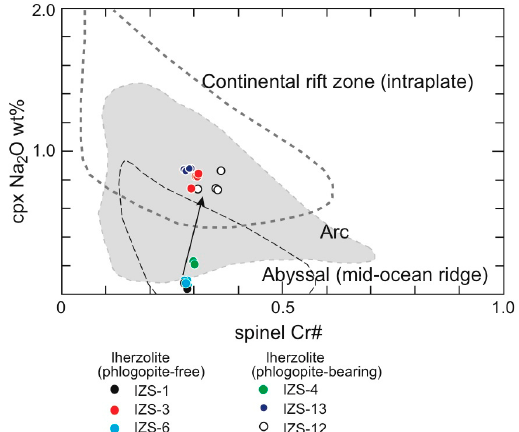
Figure 9. Relationship between Na 2 O of clinopyroxene and Cr# of chromian spinel in the Bankawa lherzolites. Note that the unmetasomatized (phlogopite-free) lherzolite contains Na-poor clinopyroxene and is similar to the abyssal peridotite. The discrimination fields are after Arai [41,70]. The arrow indicates a possible metasomatic trend. With an increase in the amount of secondary phlogopites, all the primary minerals seem to get less refractory in chemistry. The Fo content of olivine is lowered even to 87, showing a very weak positive correlation with the NiO content, in the phlogopite-bearing lherzolites (Figure 6). Pyroxenes are also slightly lower in Mg# in the phlogopite-bearing lherzolites than in the phlogopite-free ones. The Na 2 O (up to 0.9 wt %) and TiO 2 (0.5 wt %) contents of clinopyroxene are remarkably high in the phlogopite-bearing lherzolites (Table 2). Sample IZS-3 is exceptional; it is free of modal phlogopite, but its clinopyroxene is high in Na 2 O (~0.8 wt %). Chromian spinel is also enriched with Ti (up to 0.5 wt % TiO 2 ) with addition of the secondary phologopite (Table 2). The Y Fe of spinel is also slightly